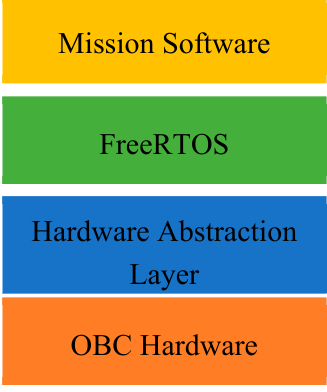
Figure 11. Flight software layers.